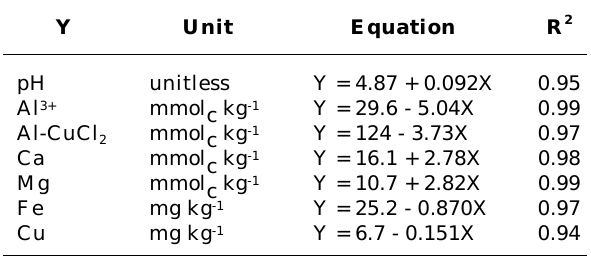
(1) Coefficients for Mn and Zn equations were not statistically significant at 5% probability level. (2) For Ca, Mg, Fe and Cu the data are only from soil samples collected after the last corn growing season (1995/96); for the others, the data represent the average of all four